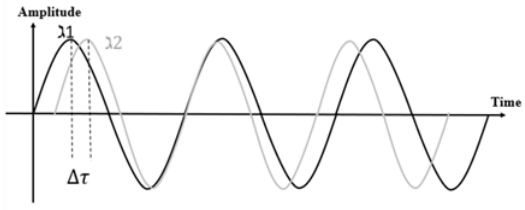
Figure 13. Delayed waveforms for subcarrier 1 and 2.